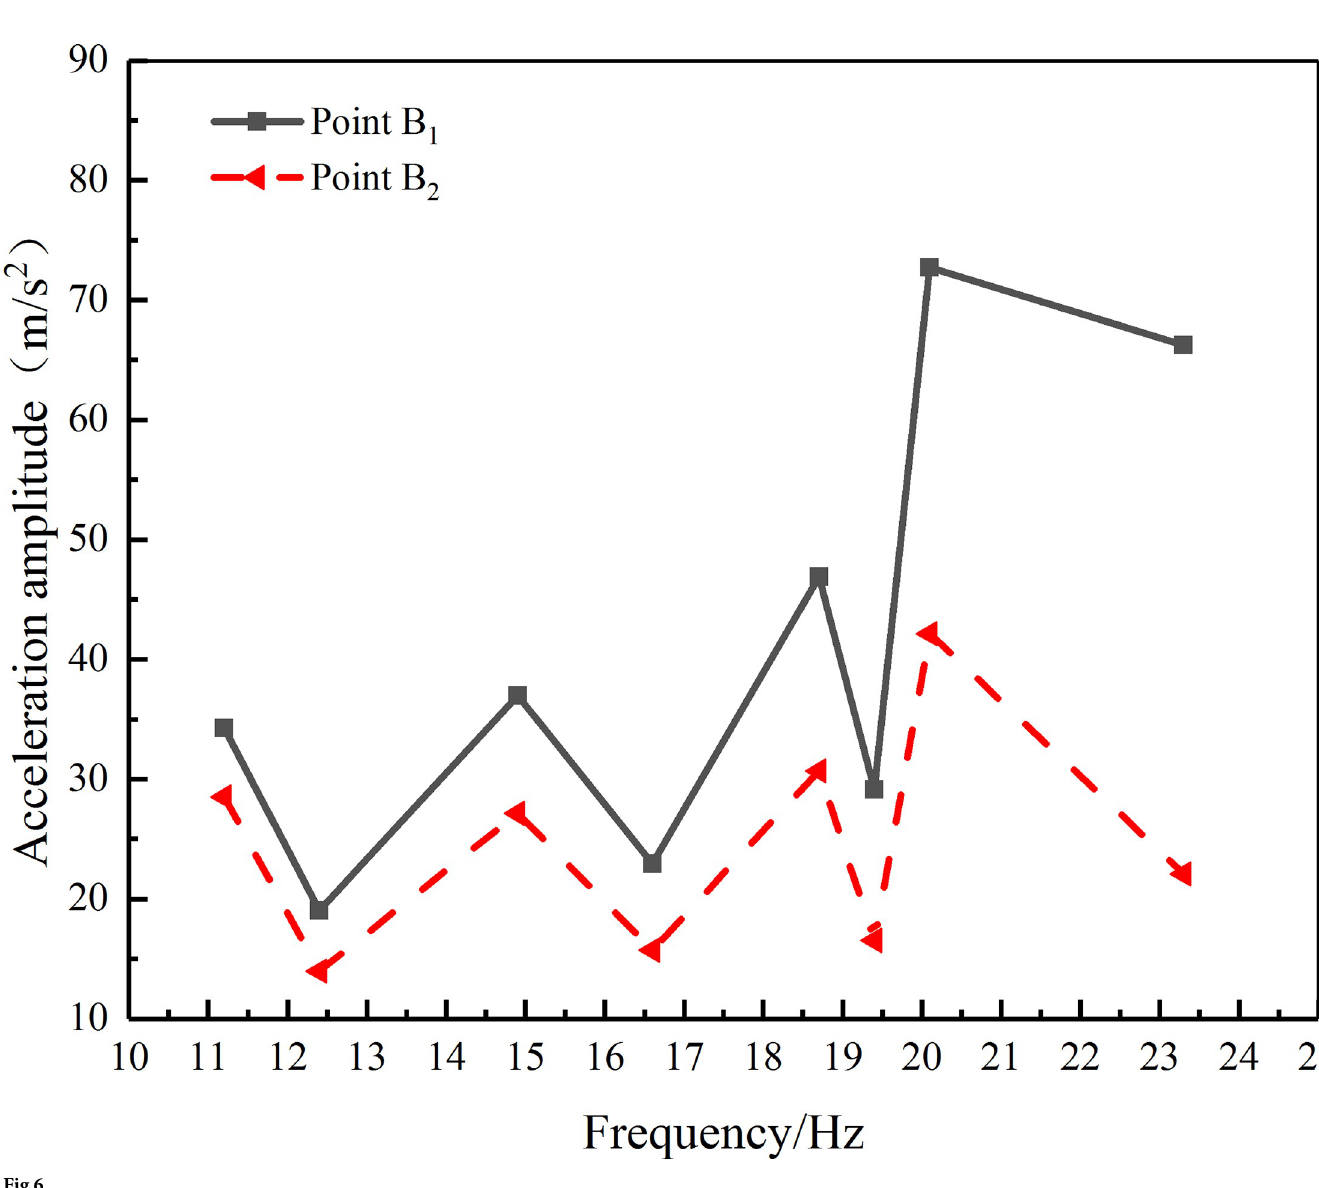
which caused the main trunk “a” to be obviously deflected to form the offshoot b shoot b was basically an extension of the trunk “a”. Therefore, when excitation of the trunk 2 “a” caused the trunk to oscillate, test point B the horizontal direction, and the maximum horizontal displacement corresponding to point P reached 22.7 mm during the oscillation. However, the point P 1 obvious movement response. The offshoot c nated by the horizontal pulling movement, and the fruit’s movement response at the test point C on this branch was also weaker. 2 When the trunk was excited by a trough point frequency of 12.4 Hz (Fig 7B), the movement response of the fruit at the test points B an excitation frequency of 11.2 Hz. However, due to the trajectory of point P